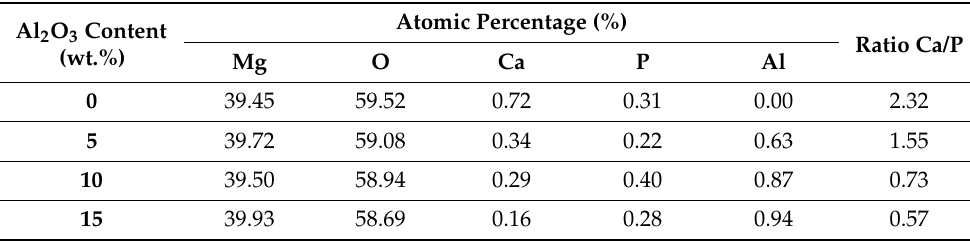
Table 3. EDX analysis for Mg-Zn/HAP/Al 2 O 3 hybrid composite with different amounts of HAP